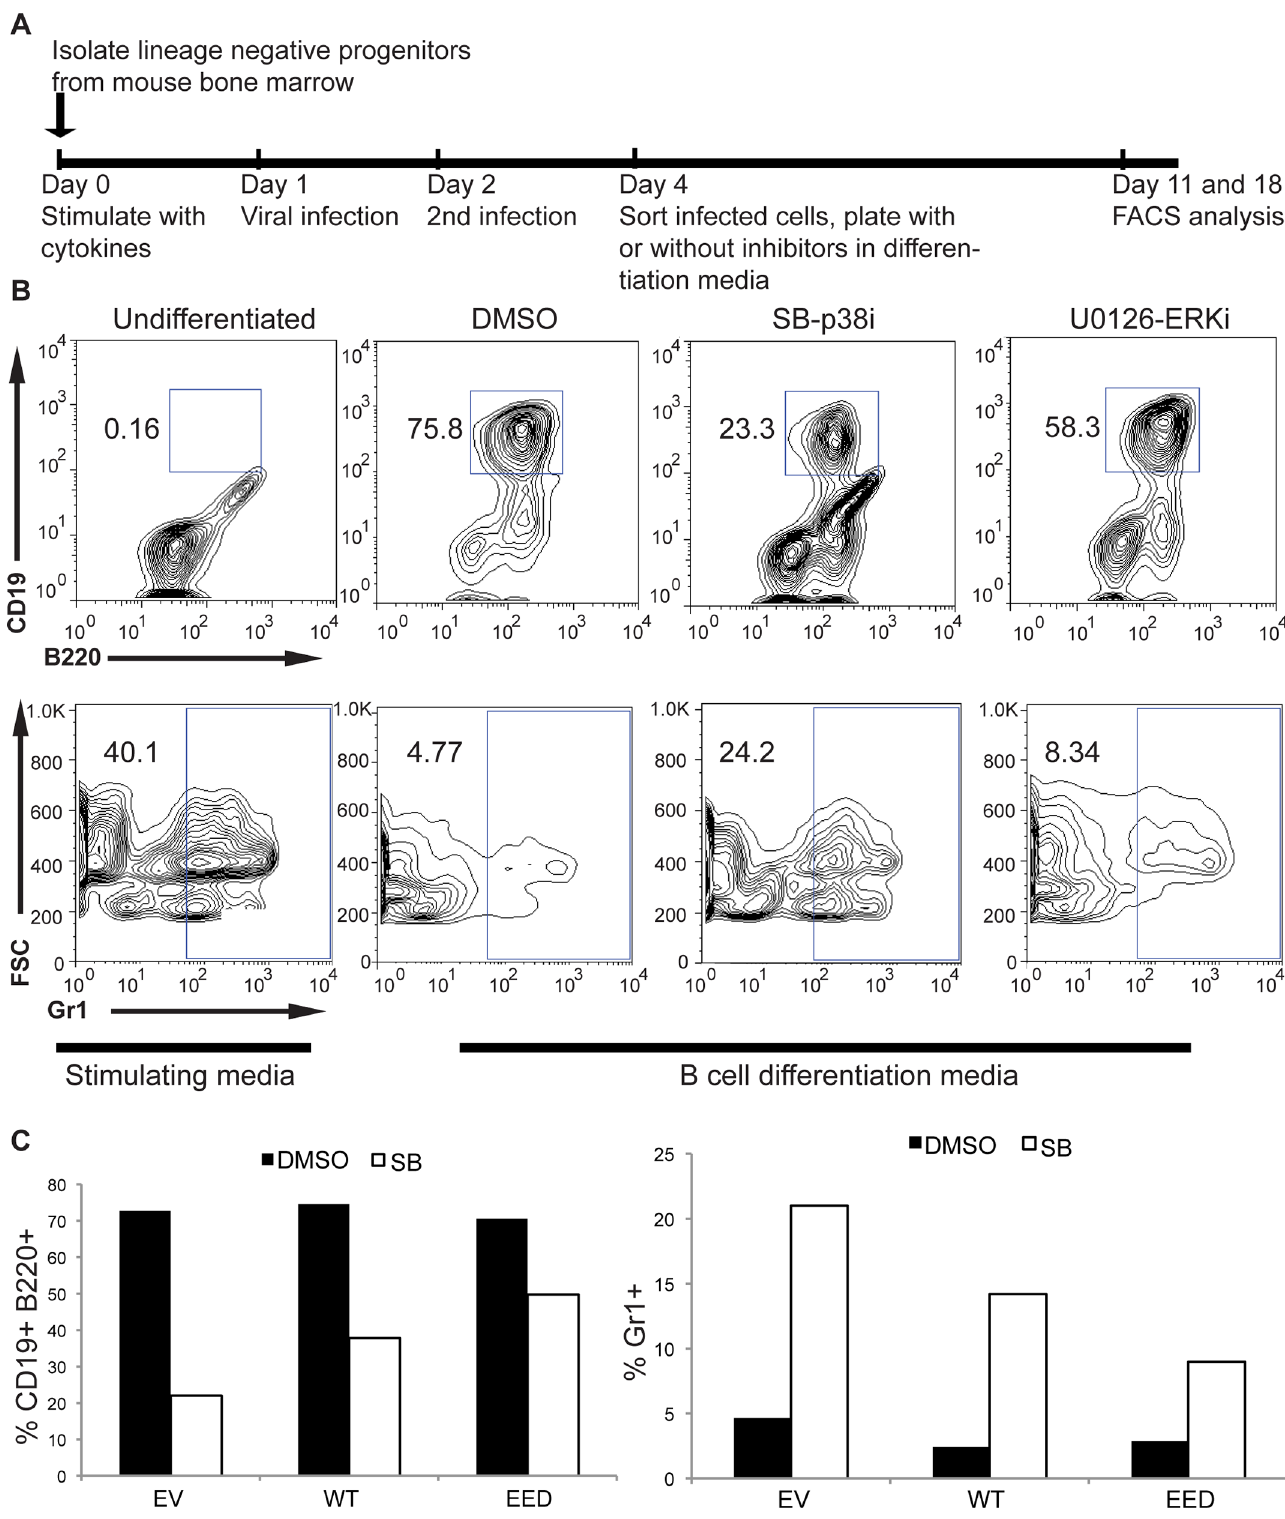
Fig 5. In vitro B cell differentiation of lineage negative progenitor cells (lin-). (A) Schematic for differentiation experiments. (B) Representative FACS plots of undifferentiated lin- cells and of those differentiated for 14 days; top panel — B220 and CD19 cell surface markers; bottom panel — forward scatter and Gr1 cell surface marker; undifferentiated cells were cultured in stimulation media; B cell differentiation cells were either untreated (DMSO), or treated with p38